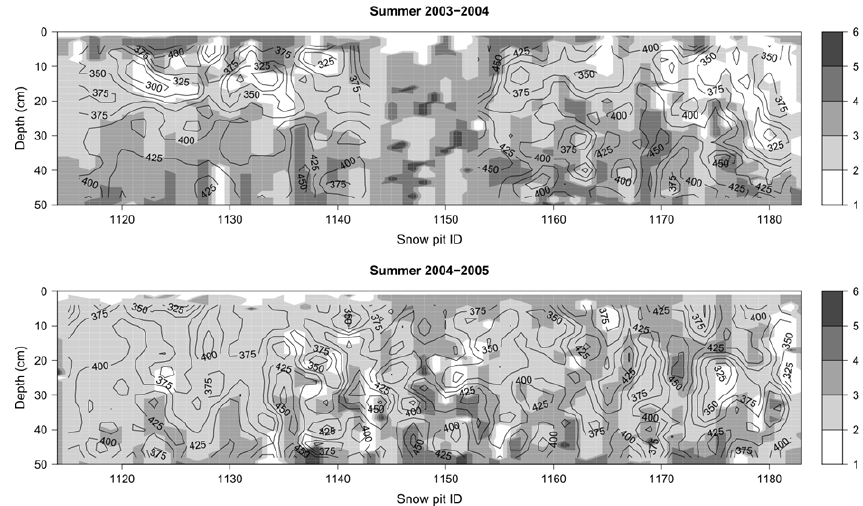
Fig. 11. Subjective layer hardness (grey scale, see Table 2) from the whole snow pit transect from 2003/2004 (top) and 2004/2005 (bottom). On the x-axis are the ordinal numbers corresponding to the snow pit sites, located 5km apart from each other (see Fig. 1). The contours indicate the snow density (in kgm − 3 ) .